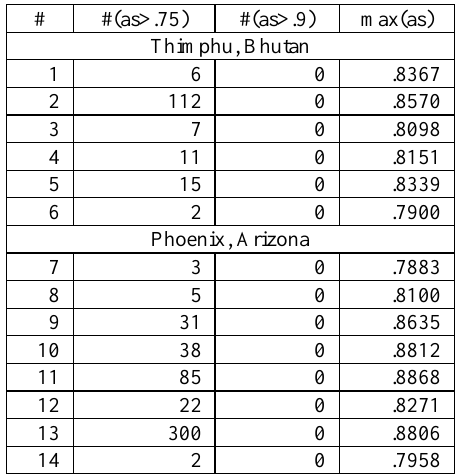
Table 2. Resulting numbers and properties of | -Gestalten